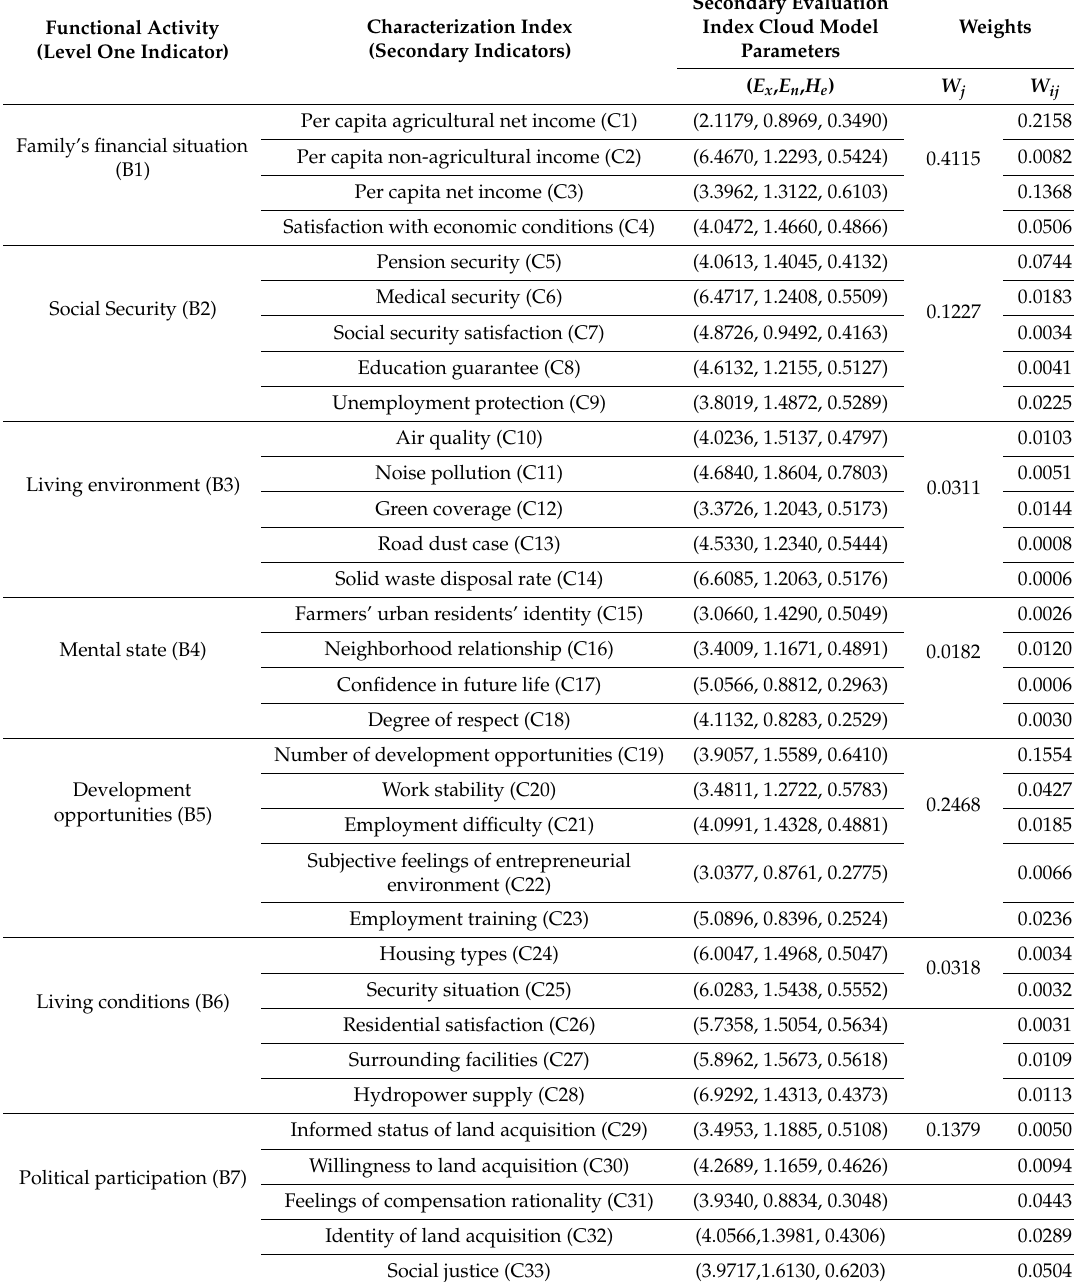
Table A1. The weight of the secondary evaluation index and the cloud model parameters of the welfare e ff ect of the asset-deficient land-lost farmers’